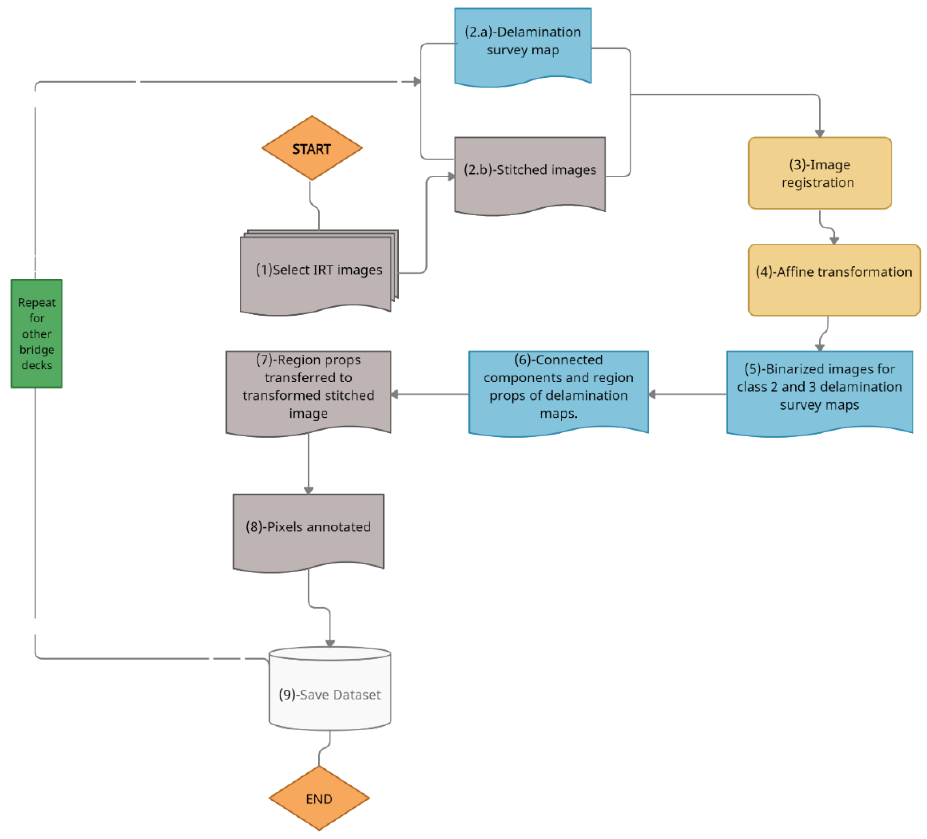
Figure 9. Flowchart for image processing and annotation of IRT.